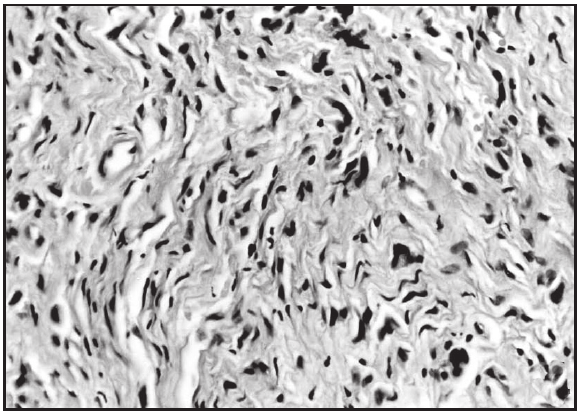
Figura 4 – Caso 2/H.E. Hipercromatismo nuclear acentuado; mitoses atípicas e bizarras também são observadas (100x)